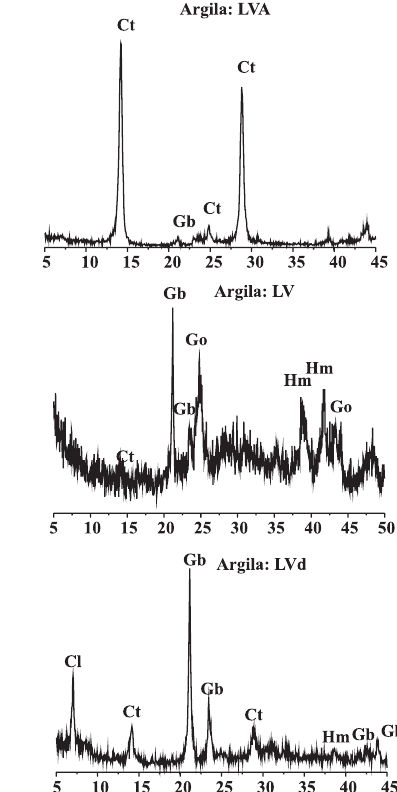
Figura 1 Análise mineralógica: difratogramas de raios X das frações silte e argila obtidos nas amostras dos solos LVA, LV e LVd, sendo: Gb: gibbsita, Hm: hematita, Go: goethita, Ct: caulinita, Qz: quartzo e